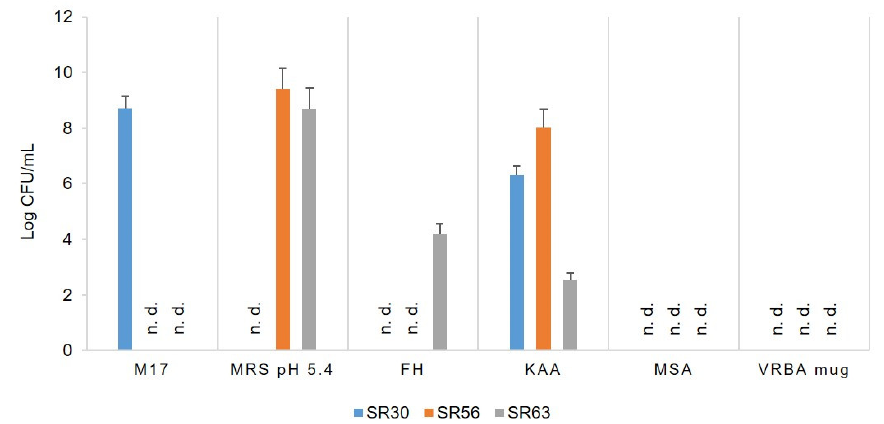
Figure 1. Microbial counts of thermophilic cocci (M17), thermophilic lactobacilli (MRS pH 5.4), mesophilic lactobacilli (FH), enterococci (KAA), staphylococci (MSA), and coliforms (VRBA mug) in the natural starter cultures SR30, SR56, and SR63. For each microbial group, counts are expressed as Log CFU/mL ± standard deviation (SD). n.d., not detected. A total of 209 isolates from the natural cultures were molecularly identified at species level: 30 S. thermophilus and 45 E. faecium were isolated from SR30. Both cocci-shaped bacteria ( E. faecium , 24 and 18) and homofermentative thermophilic lactobacilli ( L. delbrueckii subsp. lactis , 40 and 32) were isolated from SR56 and SR63, respectively, and 20 Limosilactobacillus reuteri were isolated from SR63. Thermophilic lactic acid bacteria (LAB), such as S. thermophilus and L. delbrueckii subsp. lactis , starter LAB (SLAB) predominating the early phases of acidification of scotta-innesto , cheese-making, and cheese ripening [23], are able to produce a high level of lactic acid [24] and generally dominate the microflora of the natural starter scotta-innesto, along with Lactobacillus helveticus (the latter, together with L. delbrueckii subsp. bulgaricus , is most frequently isolated from scotta-innesto used in Lazio) [25,26]. They are found also during ripening of Pecorino Romano PDO cheese together with non-starter LAB (NSLAB). Among these, mesophilic facultative heterofermentative lactobacilli (such as Lactiplantibacillus plantarum and Lacticaseibacillus casei ), thermophilic obligate heterofermentative lactobacilli (such as Limosilactobacillus fermentum ) and enterococci (such as E. faecium and E. durans ) play an important role in cheese maturation, conferring typical flavours and aromas, through processes of proteolysis, lipolysis and/or metabolism of citrate. In addition, some strains can be able to produce bacteriocines, or are known to have probiotic activity [21,27–30]. As previously reported by Chessa et al. [11,12], in scotta-innesto for Pecorino Romano cheese, L. reuteri — an obligatory heterofermentative LAB able to follow metabolic pathways leading the development of aromas precursors enhancing the sensory quality of the final product [31], which can have probiotic properties with beneficial effects on human health [32–35]—was also found. Moreover, L. reuteri can also contribute to the safety of dairy products by producing antimicrobial substances, such as reuterin, able to inhibit growth of several pathogens such as Listeria monocytogenes , Escherichia coli O157:H7 (EHEC) [36], Staphylococcus aureus , Salmonella choleraesuis ssp. choleraesuis , Yersinia enterocolitica , Aeromonas hydrophila ssp. hydrophila and Campylobacter jejuni [37]. Enterococci are NSLAB involved in the development of sensory richness in several traditional cheeses of the Mediterranean area, exerting proteolytic and lipolytic activity, and citrate metabolism [28]. However, their role in fermented foods is controversial, since some enterococci—in particular E. faecium, ubiquitous of dairy products and gastrointestinal tract of humans and animals [38]—are often resistant to antibiotics and potential human pathogens [28,39,40]. The secondary adventitious microflora belonging to the genera Staphylococcus , which is useful for conferring typical characteristics to the cheese [29], was not found in the cultures investigated in this study.